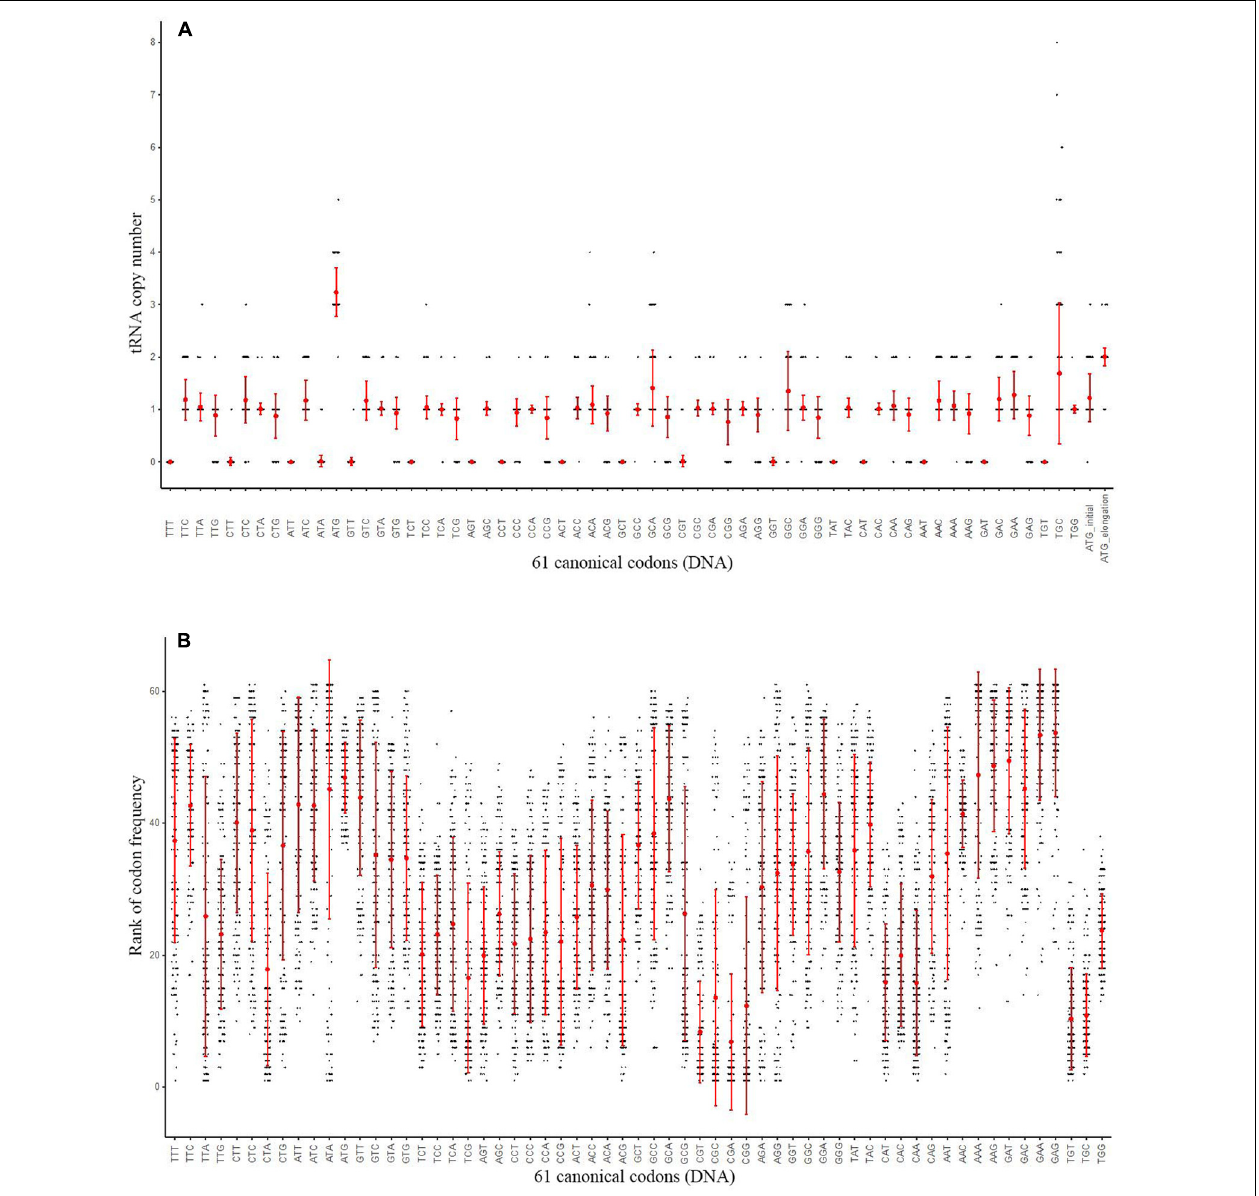
FIGURE 2 | The tRNA copy number and rank of codon frequency for 61 different codons of 167 archaeal genomes. (A) tRNA copy number for corresponding codons in Archaea genomes. X -axis indicates tRNA types for different codons, while Y -axis indicates copy number of tRNA. Copy number for one codon in one species is present as one point. Two types of tRNA pairing Met were also indicated. The error bar of both (A,B) indicates standard deviation for each kind of codon or tRNA. (B) Rank of codon frequency for 61 codons. X -axis indicates codon types, while Y -axis indicates frequency rank. More frequent codons are shown with higher rank numbers. The rank of one codon in one species is presented as one point. The order of codon in (A,B) are the